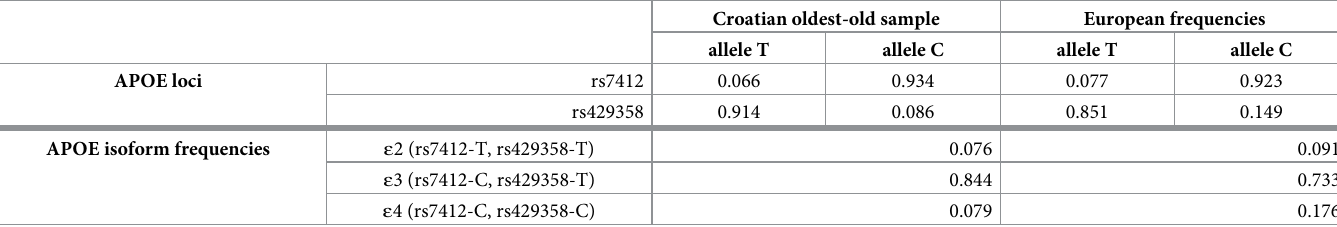
Croatian oldest-old sample